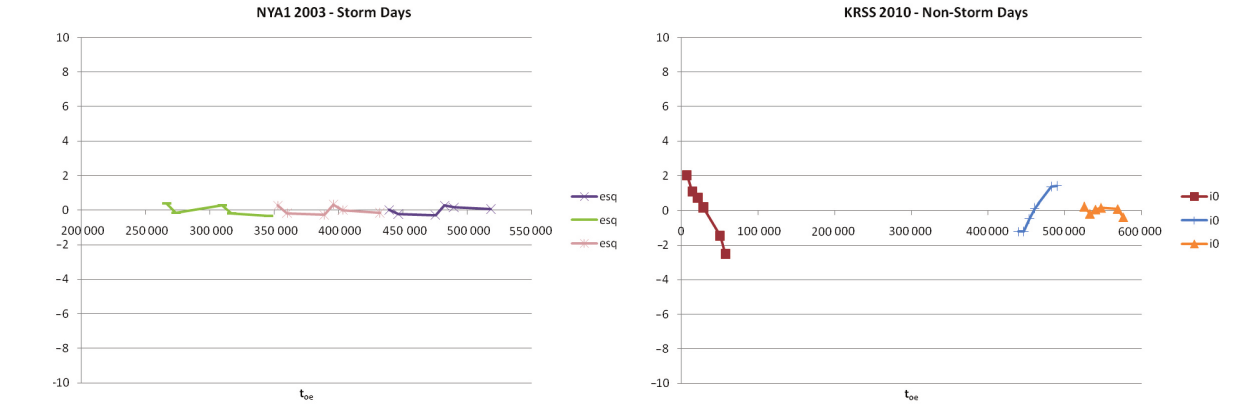
Fig. 12. Inclination for three stormless days in 2010 using cPOS stations (KRSS)